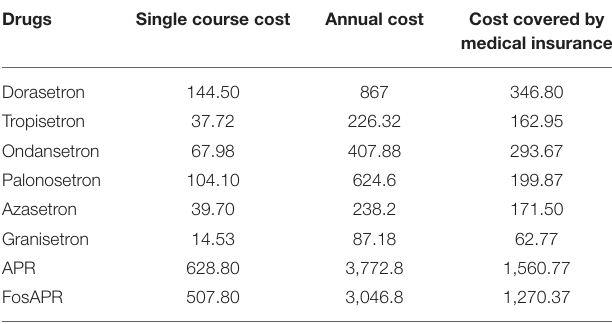
TABLE 8 | Single course cost, annual cost, and cost covered by medical insurance of antiemetic drugs. Drugs